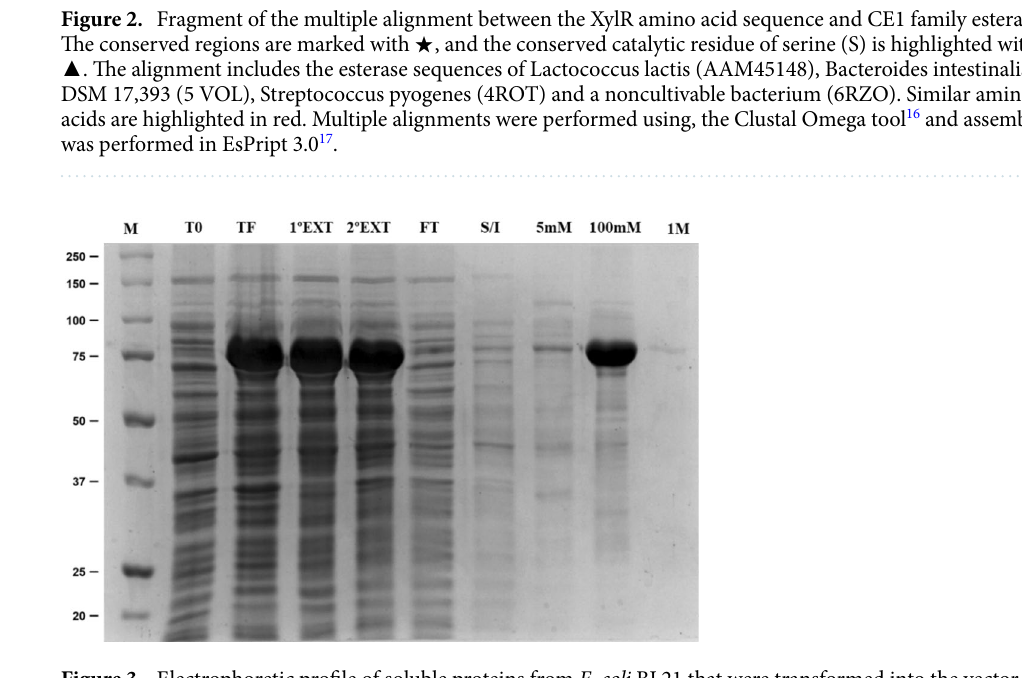
Figure 3. Electrophoretic profile of soluble proteins from E. coli BL21 that were transformed into the vector pET28a/ORF1374. Purification was performed by affinity chromatography on Ni–NTA resin. Channels: (M) Precision Plus marker; (T0) Time before induction; (TF) After 22 h of induction; (1°EXT) First extract; (2nd EXT) Second Extract; (FT) Flow through; (S/I) Fraction without imidazole; (5 mM) Fraction with the concentration of 5 mM imidazole; (100 mM) Fraction with 100 mM imidazole concentration; and (1 M) Fraction with a concentration of 1